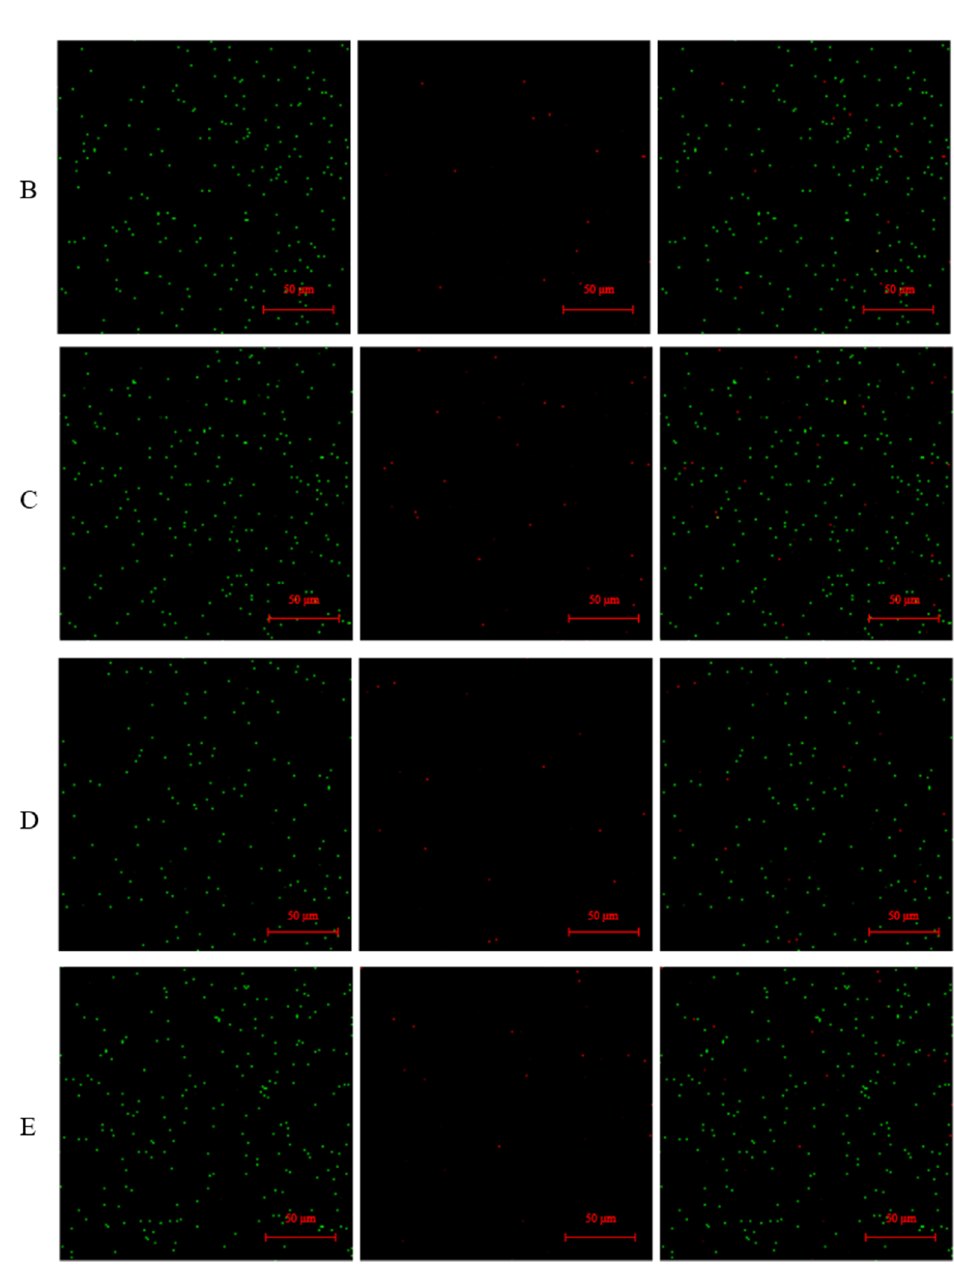
Figure 7. Laser confocal microscopy combined with dye to discriminate between live and dead bacteria. ( A – E ) denoted yogurt with different combinations of LC + LD + ST, LF + LD + ST, LB + LD + ST, LA + LD + ST, and LD + ST, respectively. The green fluorescence on the left indicated the live bacteria in the yogurt, whereas the red fluorescence in the middle indicated the dead bacteria in the yogurt, and the combination of the two is shown on the right.